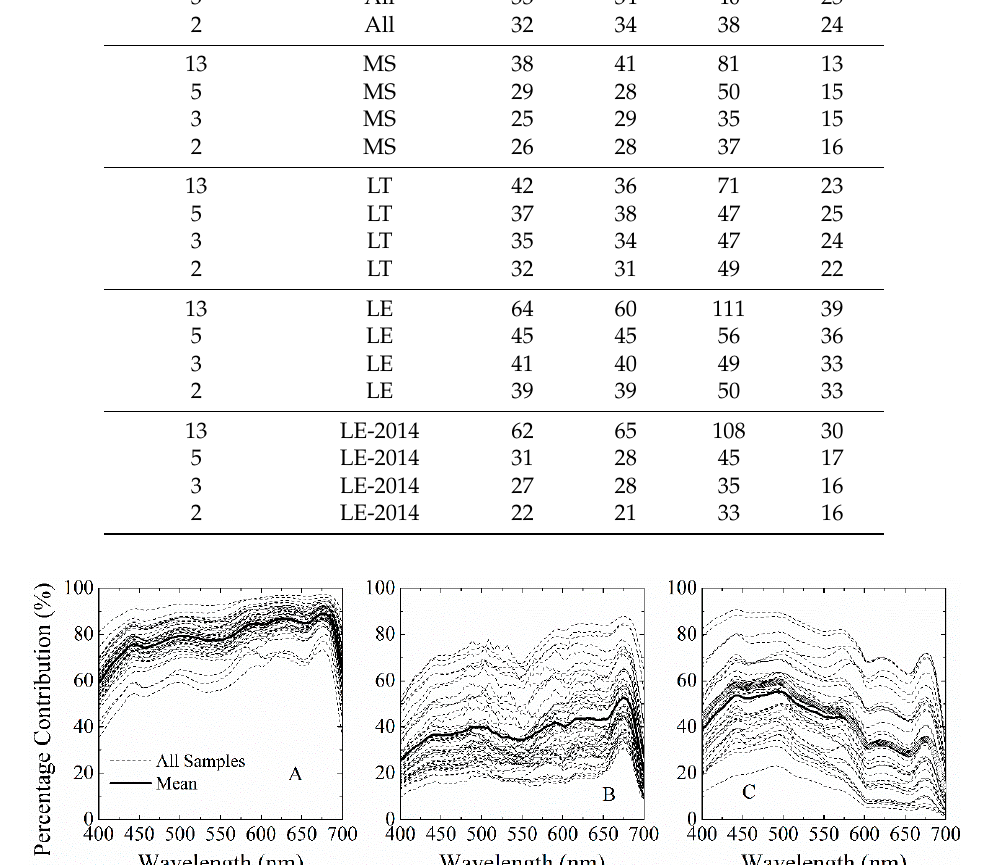
Figure 4. Percent contribution of phytoplankton absorption coefficients ( a ph ( λ )) to the total absorption coefficient ( a ( λ ) = a w ( λ ) + a dg ( λ ) + a ph ( λ ), with a w ( λ ) and a dg ( λ ) as the absorption coefficients of pure seawater and non-algal particles and gelbstoff) for three datasets (all the samples and their mean values): ( A ) Mississippi ponds (MS); ( B ) Lake Taihu (LT); and ( C ) Lake Erie (LE). Once a Gau (435) and a Gau (617.6) were obtained from R rs ( λ ), the other peaks could be estimated from